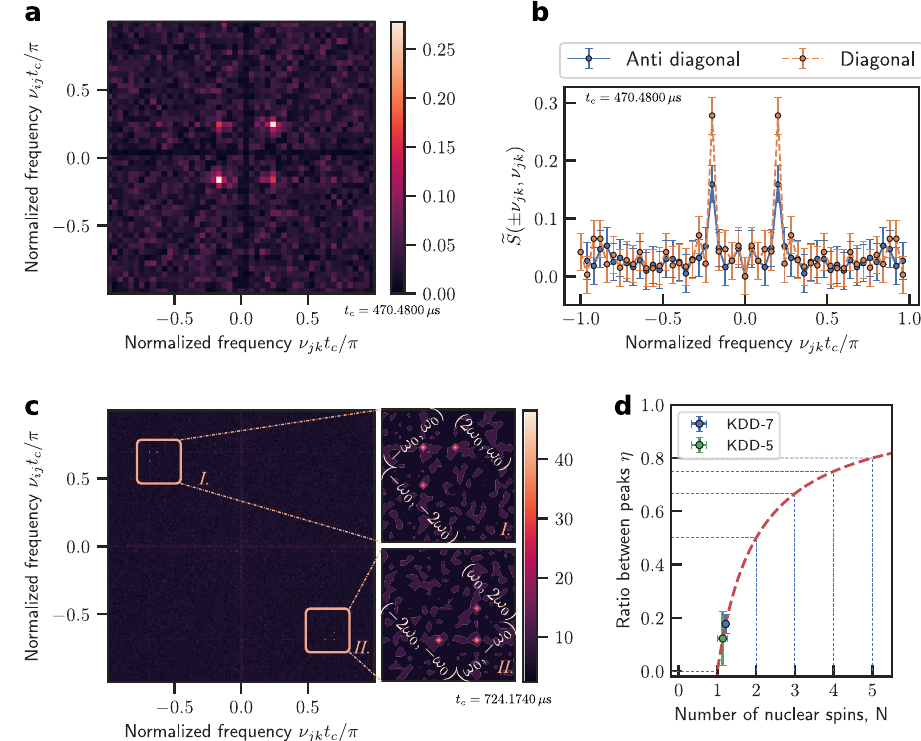
Fig. 3 | Quantum nonlinear spectroscopy of a nuclear spin and a random- phasedAC fi eld.a 2Dspectrumofthethirdmoment e S coupled to a nuclear spin. b The diagonal (orange symbols) and anti-diagonal (purple symbols) slice of a . c 2D spectrum of the third moment e S centerspincoupled to a random-phased AC fi eld. d The calculated averageheight